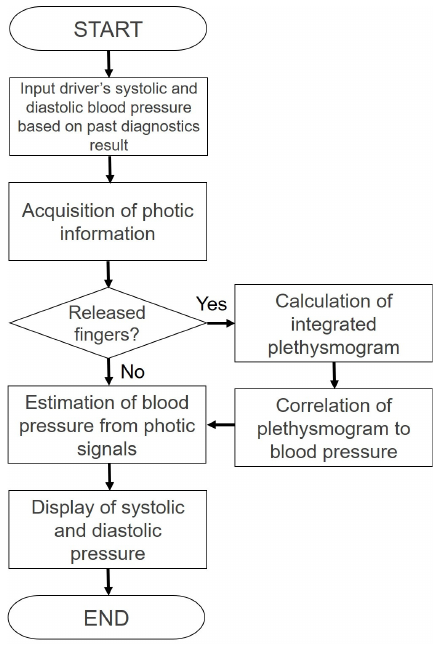
Figure 5. Flow chart estimating continuous blood pressure using a